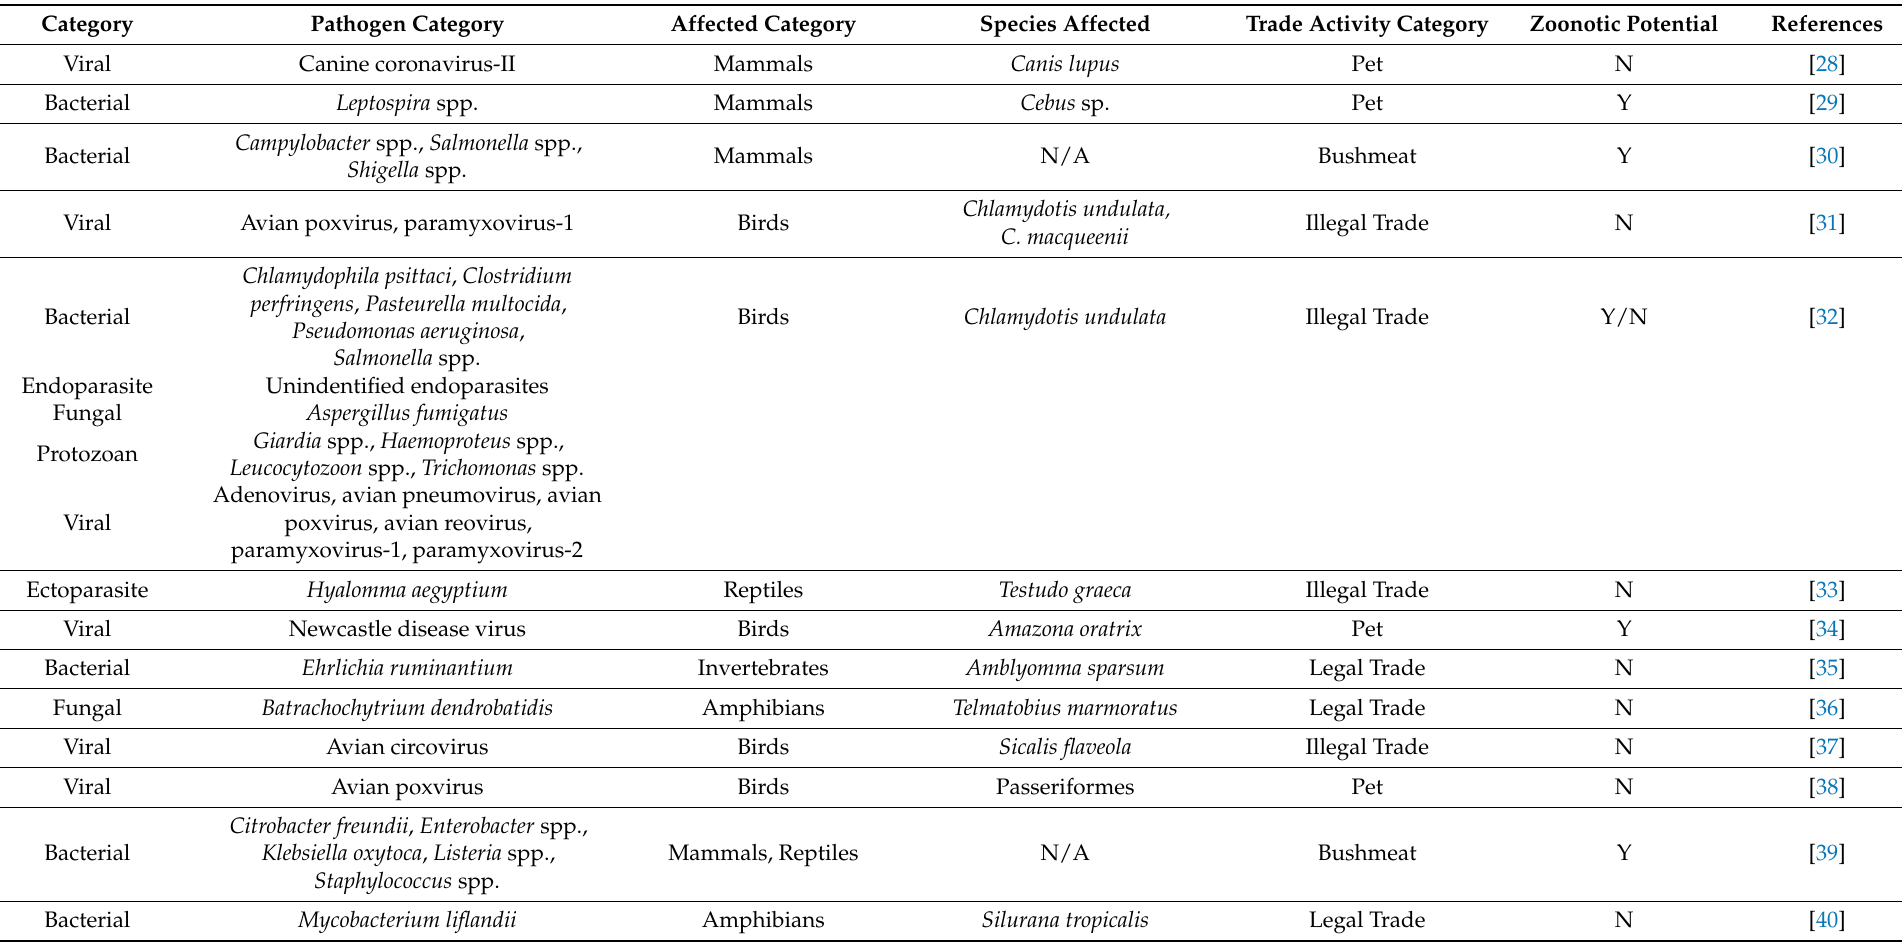
Table 1. Pathogens including viruses, bacteria, fungi, endoparasites, and ectoparasites including genus and species when known, hosts affected, implicated illegal wildlife trade activity and zoonotic potential documented in the literature reviewed,